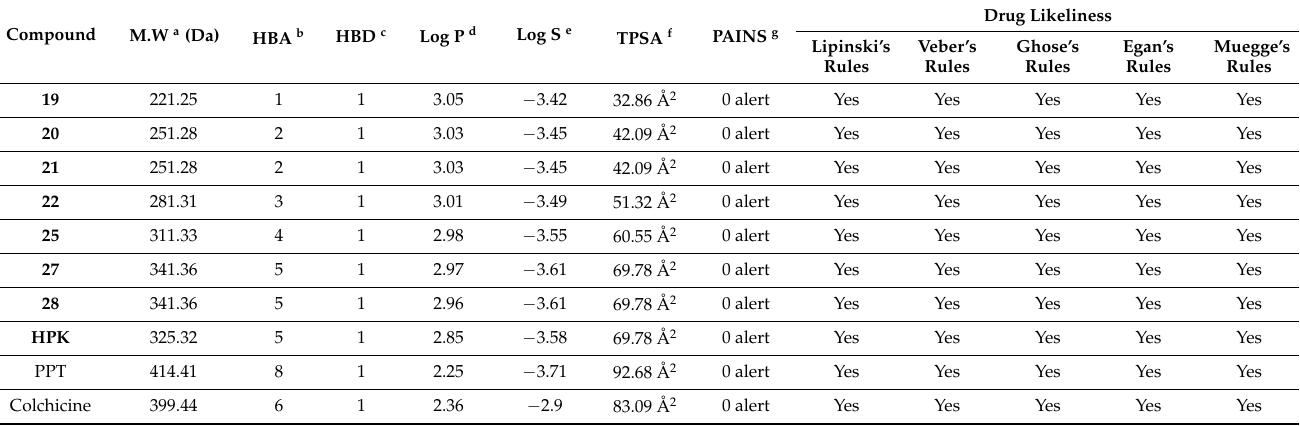
Table 6. Drug-likeness predictions of tested